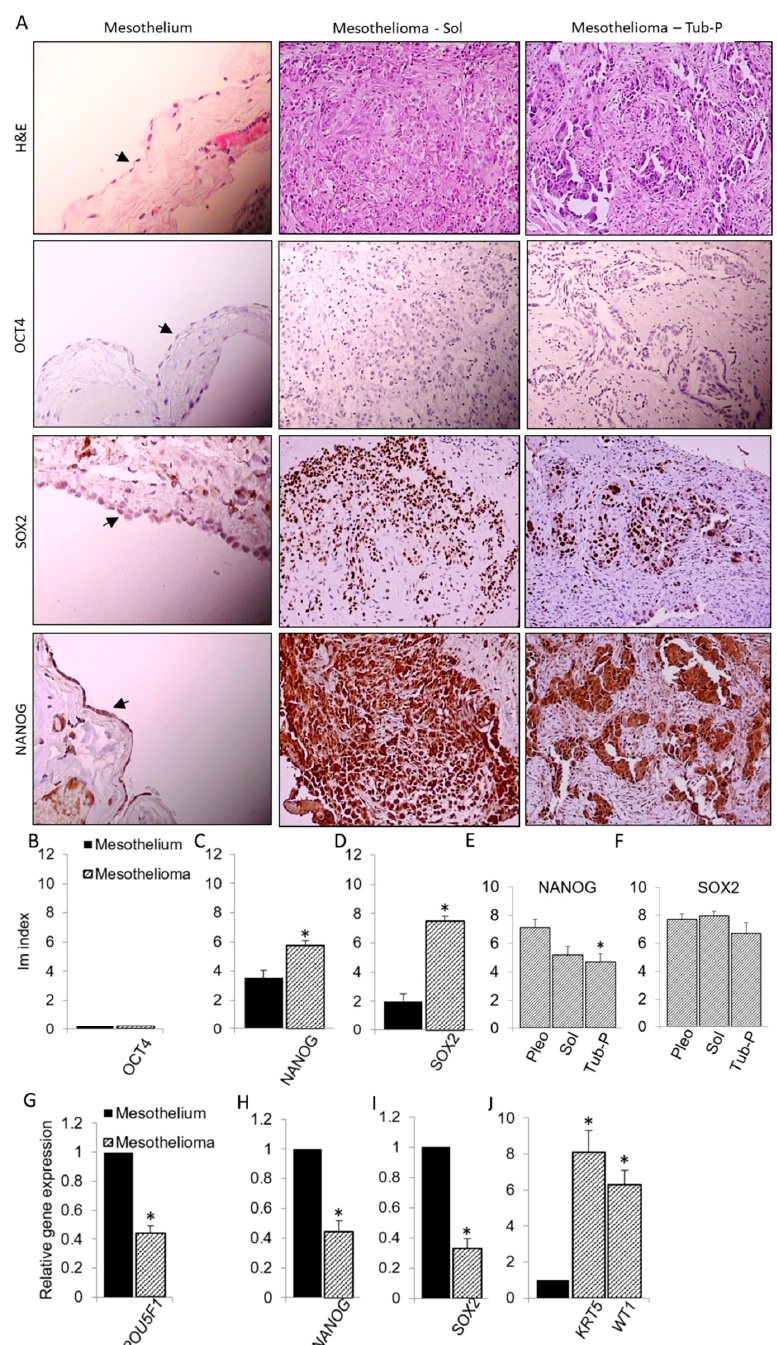
Figure 1. OCT4 / POU5F1 , NANOG and SOX2 expression in mesothelioma. ( A ) Representative images of normal mesothelium and two histological subtypes of mesothelioma, solid (Sol) and tubulopapillary (Tub-P) are shown. Each sample was analyzed by H&E staining and immunohistochemical detection of OCT4, NANOG and SOX2 proteins. Mesothelium images are magnified x400 and arrow marks monolayer of mesothelial cells. Other images are magnified × 200. ( B – D ) Summary data of Im index for each protein, representing relative expression of each protein in mesothelium and all mesothelioma samples. ( E and F ) Comparison of Im index among three subtypes of mesothelioma, pleomorphic (Pleo), Sol and Tub-P. ( G – J ) Shown are summary data of relative expression of pluripotency genes POU5F1 , NANOG and SOX2 , and mesothelioma marker genes KRT5 and WT1 . Data are means ± SEM; * p < 0.05 vs Mesothelium or